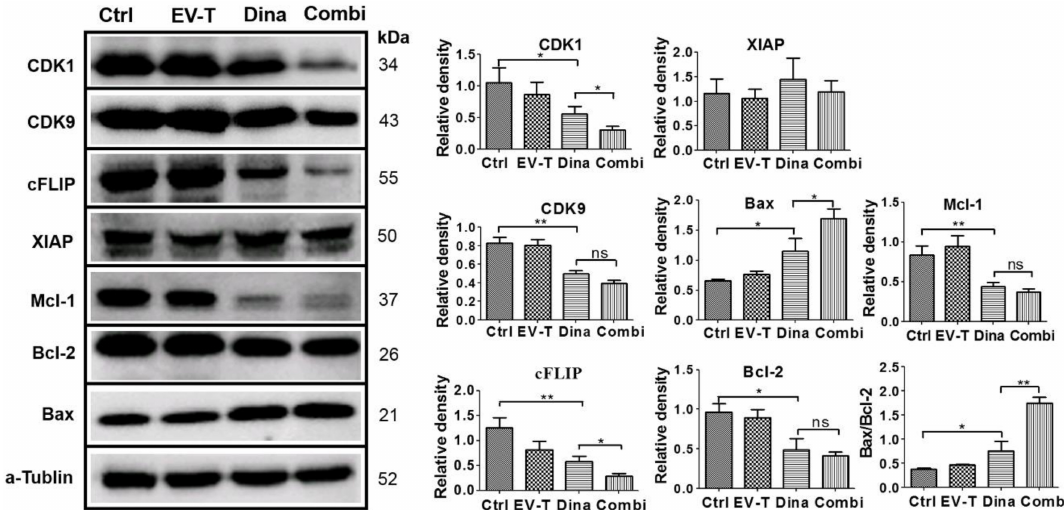
Figure6. ExpressiondetectionofTRAILsignalingpathwaymodulatorsinA549cellsbyimmunoblotting. Cells were treated by vehicle (Ctrl), 1.0 ng / mL of EV-T (EV-T) or / and 15 nM of dinaciclib (Dina) (Combi) for 24 h, respectively, followed by Western blotting analysis with antibodies against CDK1,